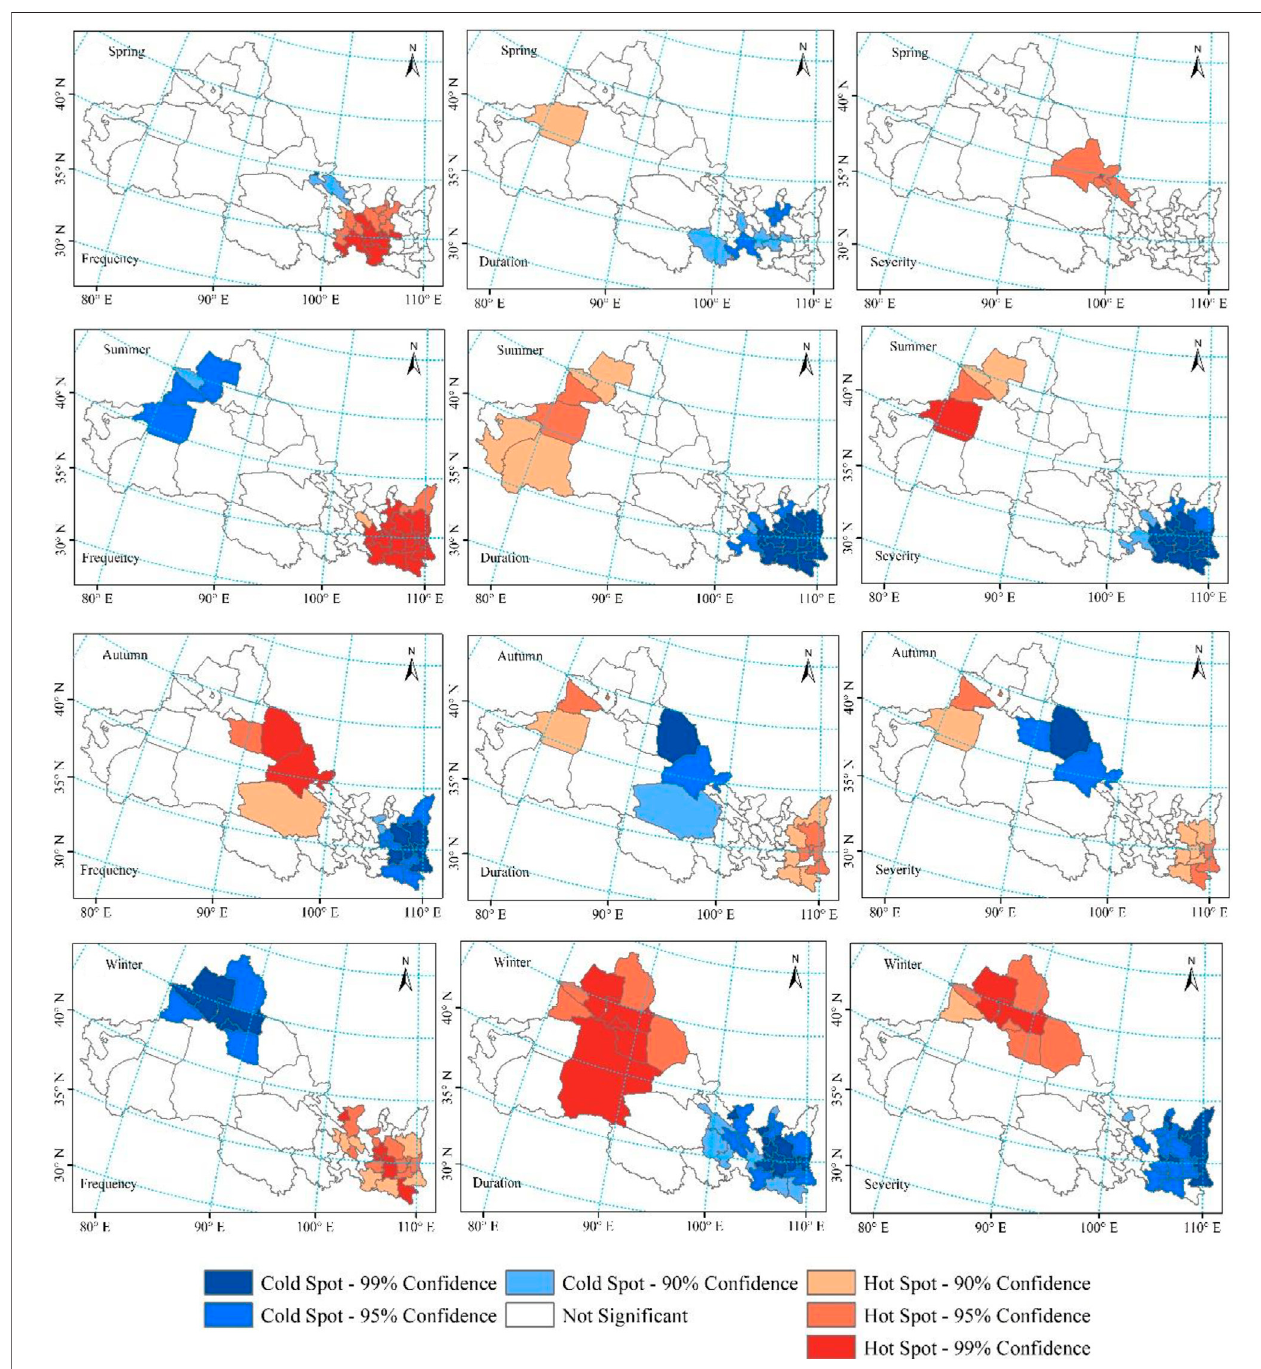
FIGURE 15 | Spatial autocorrelation pattern of cold hot spots of seasonal drought variables.